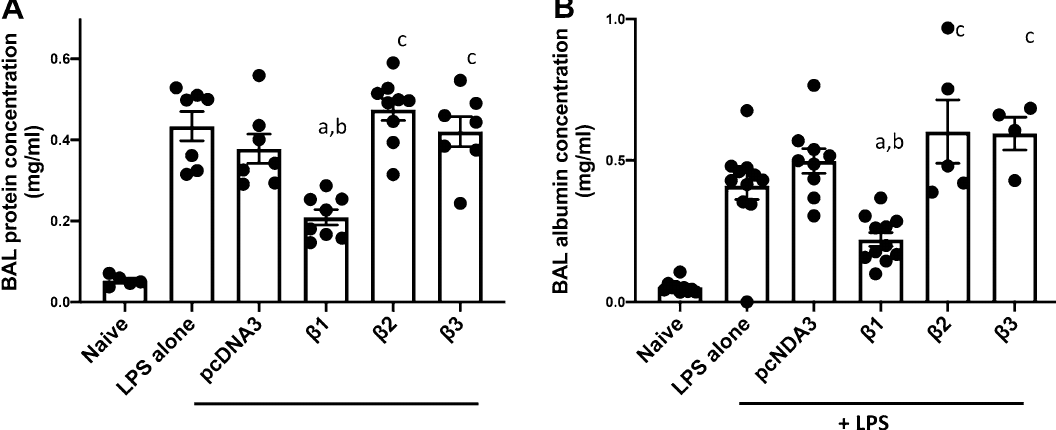
Figure 6. Gene transfer of the β2 and β3 subunits of the Na,K-ATPase fail to reduce protein levels in the BAL in LPS-injured lungs. Lung injury was established in C57B6 mice (n = 6–8) by aspiration of LPS (5 mg/ kg) and 1 day later plasmids (100 μg each) expressing either no insert (pcDNA3), the β1, β2, or β3 subunits of the Na + ,K + -ATPase (β1, β2, or β3) were delivered in 50 μl to the lungs by aspiration followed immediately by electroporation. Two days after gene delivery, lungs were lavaged with PBS and BAL fluid was collected and analyzed for total protein ( A ) or serum albumin ( B ). All experiments were carried out three times and a representative experiment is shown. One-way ANOVA with post-hoc Tukey’s multiple comparisons was used for statistical analysis; For total protein ( A ) a, p < 0.001 compared to LPS alone; b, p < 0.01 compared to LPS + pcDNA3; c, p < 0.001 compared to LPS + β1. For Albumin ( B ) a, p < 0.001 compared to LPS alone; b, p < 0.001 compared to LPS + pcDNA3; c, p < 0.001 compared to LPS +